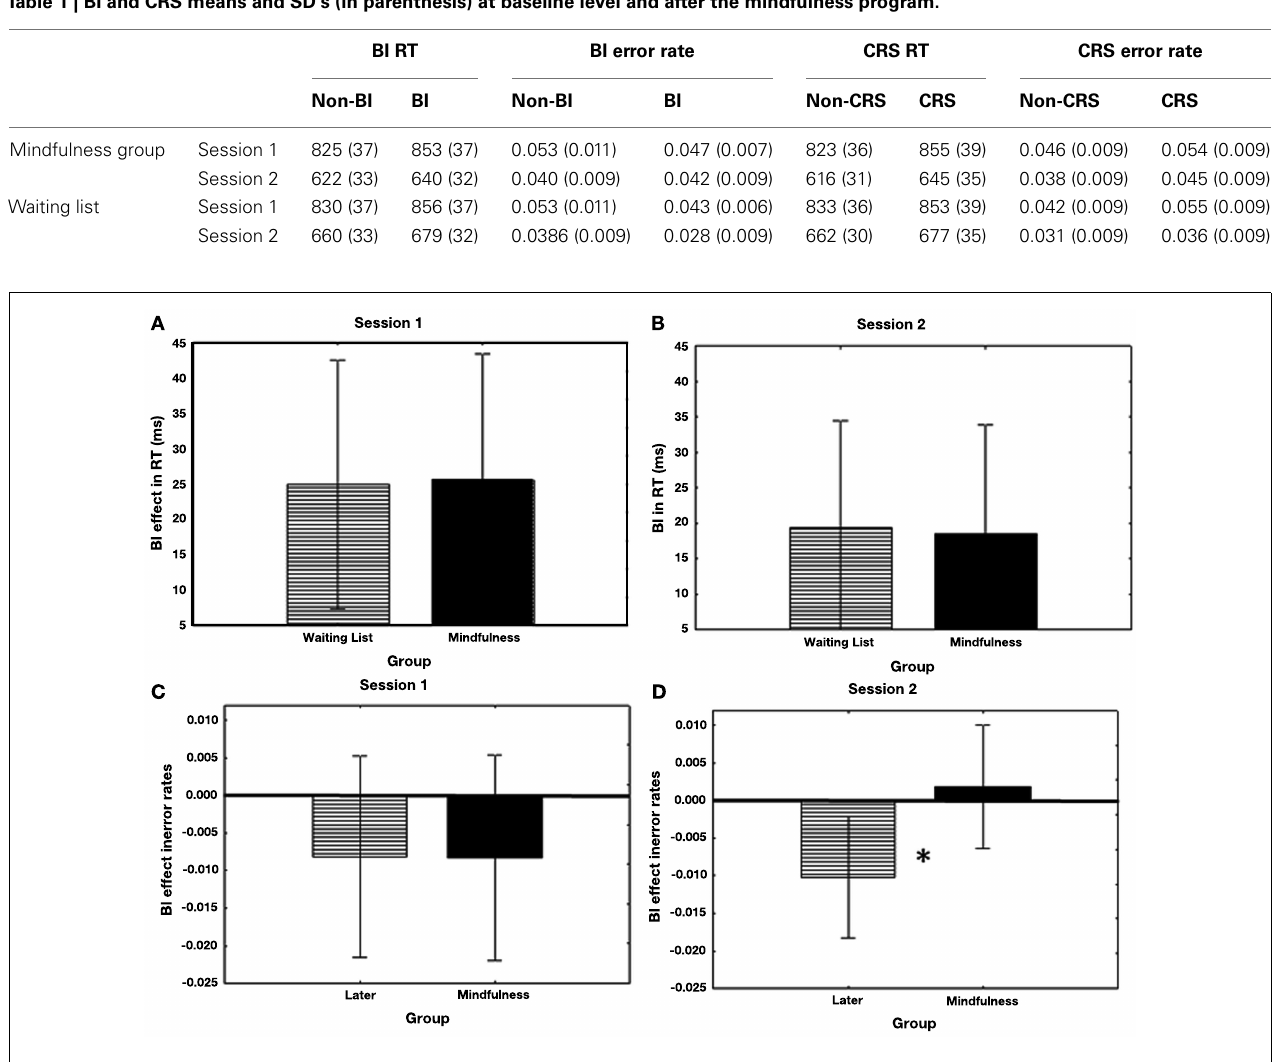
FIGURE 3 | BI RT’s and error rates at baseline level and after the mindfulness program. Backward Inhibition (ABA task sequence trials-CBA task sequence trials) according to Group in (A) RT in Session 1, (B) Error Rate in Session 1, (C) RT in Session 2, and (D) Error Rate in Session 2.The positive BI effect in RT (A) and negative BI effect in Error Rate (B) suggest a speed-accuracy tradeoff, with no reliable BI effect